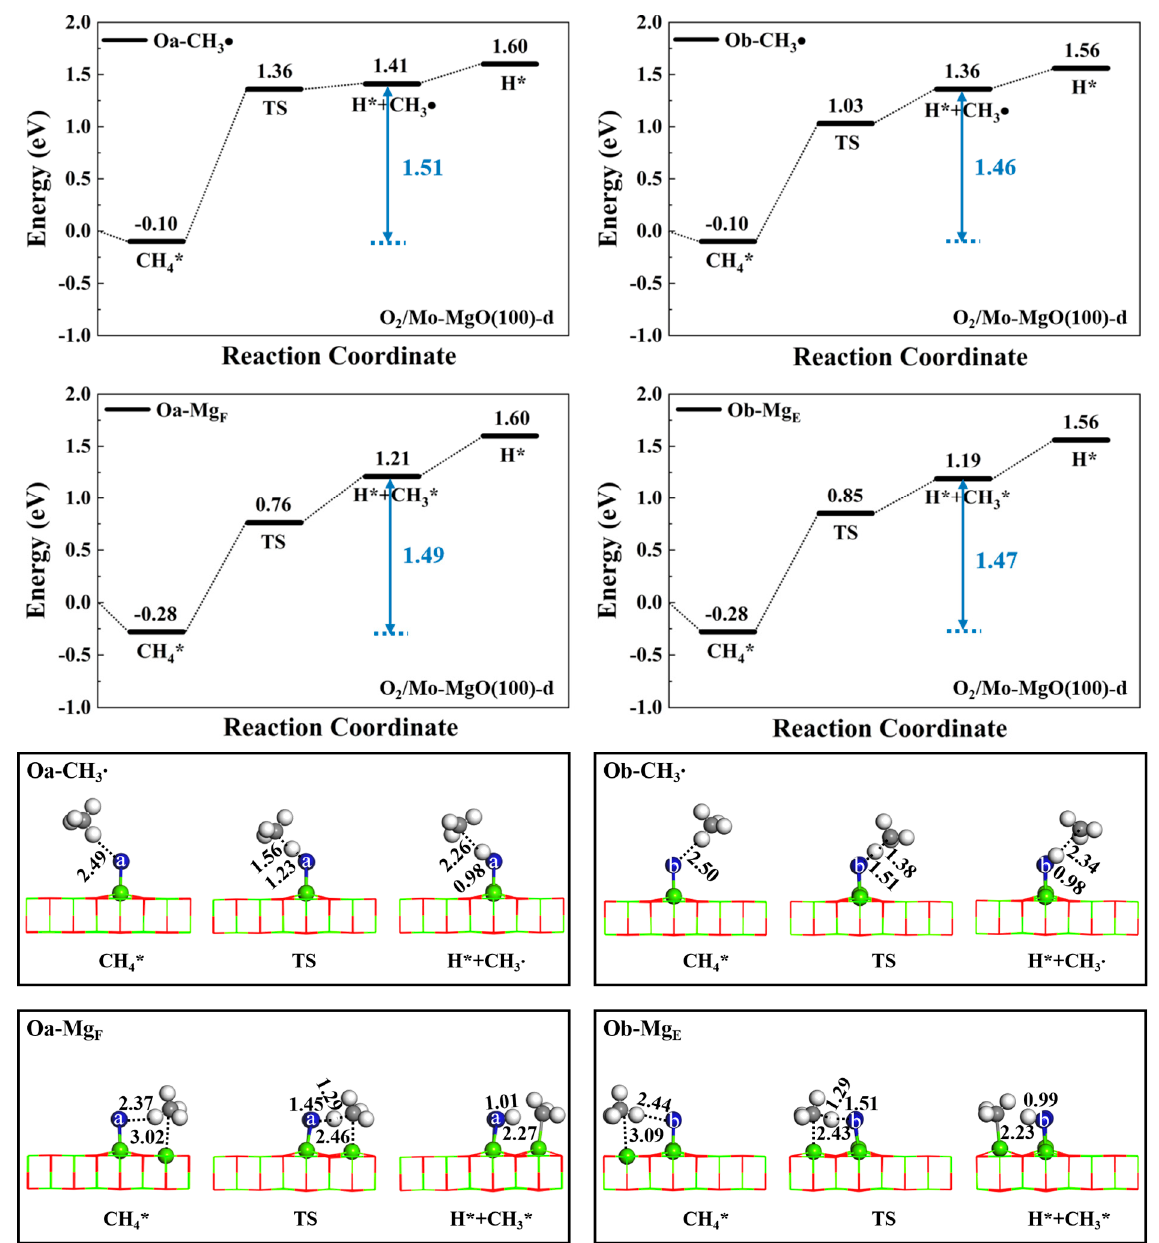
Figure 2. The dissociation energy (E disso ) and desorption energy (E de ) of methane at various sites on Mo-doped MgO(100). The labels associated with binding sites are indicated in Figure 1 dopant ef- fects in OCM but also provide insight into the future design of the doped metal oxide catalyst.